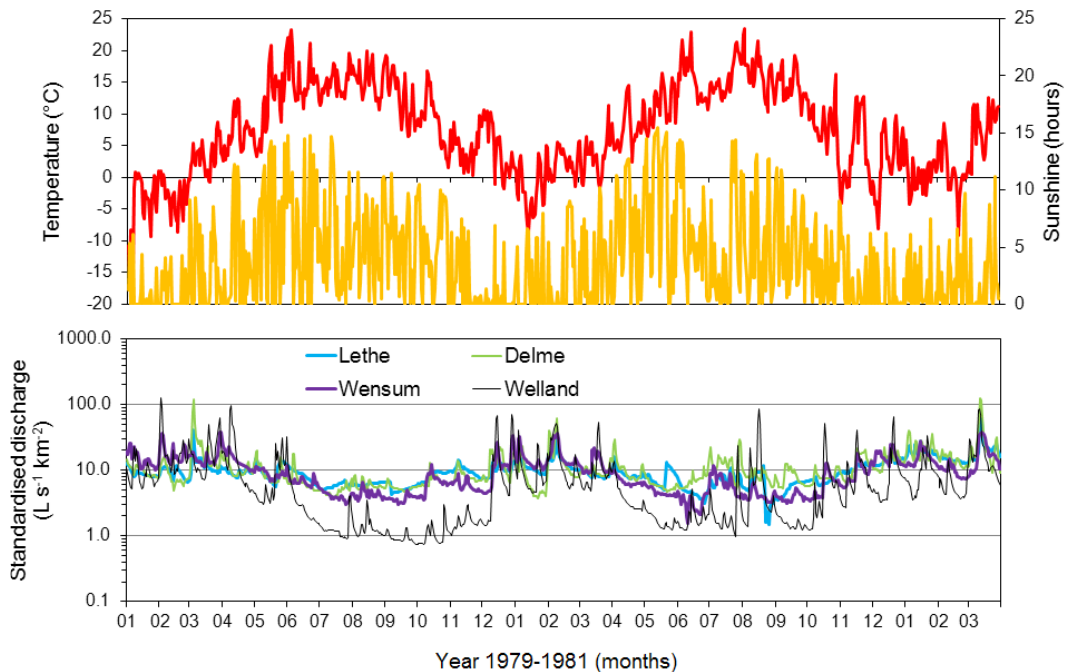
Figure A1. Mean daily average change in temperature (red) and sunshine duration (orange) from Bremen (Germany) and standardised discharge over two years for German and English rivers.